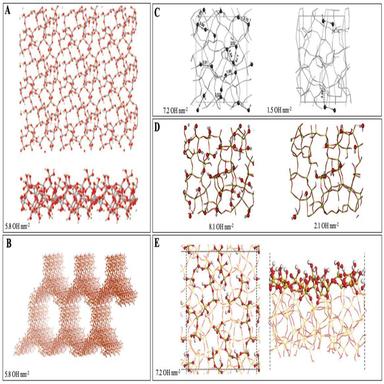
Models of amorphous silica having different silanol coverages (OH nm−2 ): (A) a top view (above) and a side view (below) of the silica slab model developed by Tielens et al. with the 5.8 OH nm−2 . Adapted with permission from ref., Copyright © 2008 American Chemical Society; (B) a model of the MCM-41 mesoporous silica developed by Gierada et al. with the 5.8 OH nm−2 . Reproduced from ref. with permission from the PCCP Owner Societies; (C) models developed by Ugl